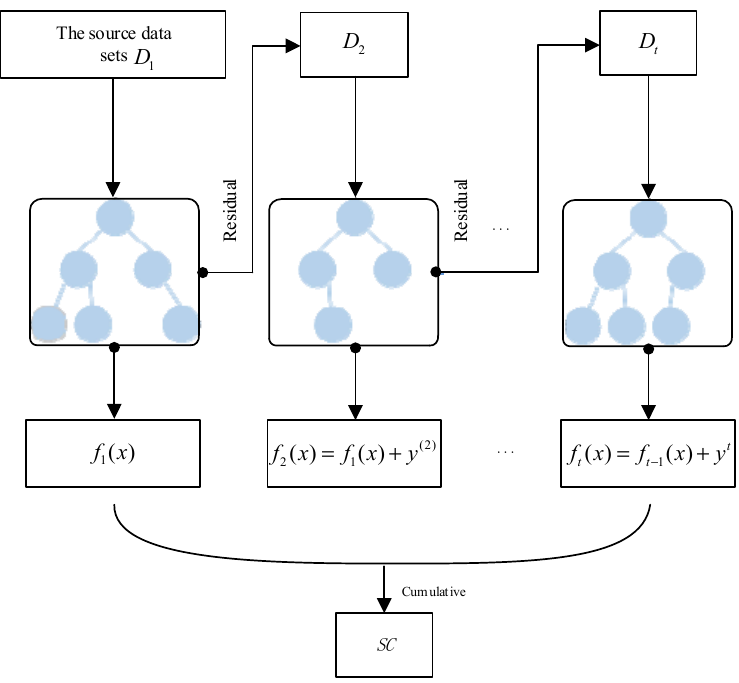
Figure 3. Schematic diagram of XGBoost structure.